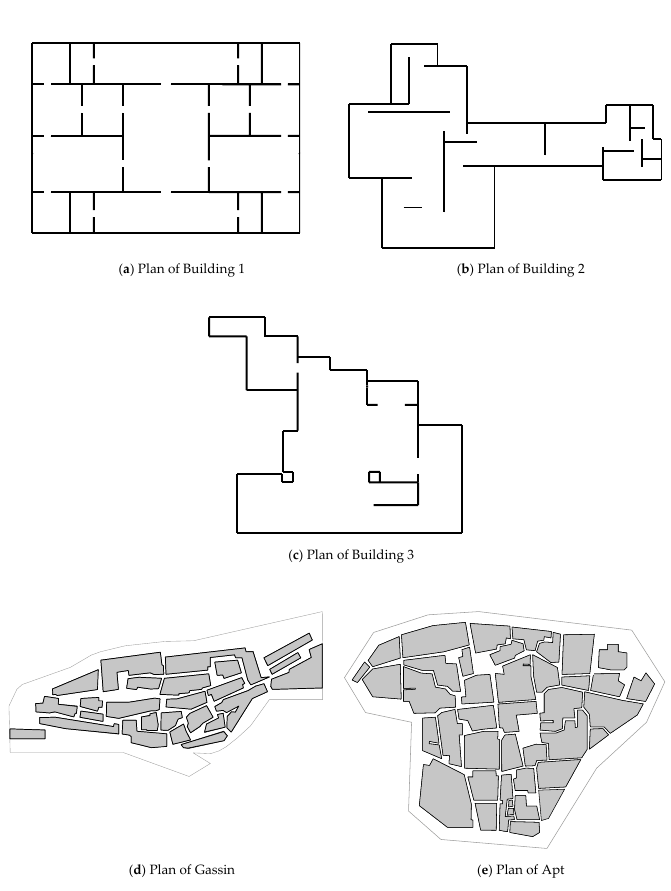
Figure 5. Cases of Buildings and Urban Layout. ( a ) Plan of Building 1 (Source [2]) ( b ) Plan of Building 2 (Source [2]) ( c ) Plan of Building 3 (Source [2]) ( d ) Plan of Gassin (Source [2]) ( e ) Plan of Apt (Source [2]). (The authors, S.K.J and Y.K., redraw original figures in [2] with permission of the authors, Peponis et al. [2]) 6.